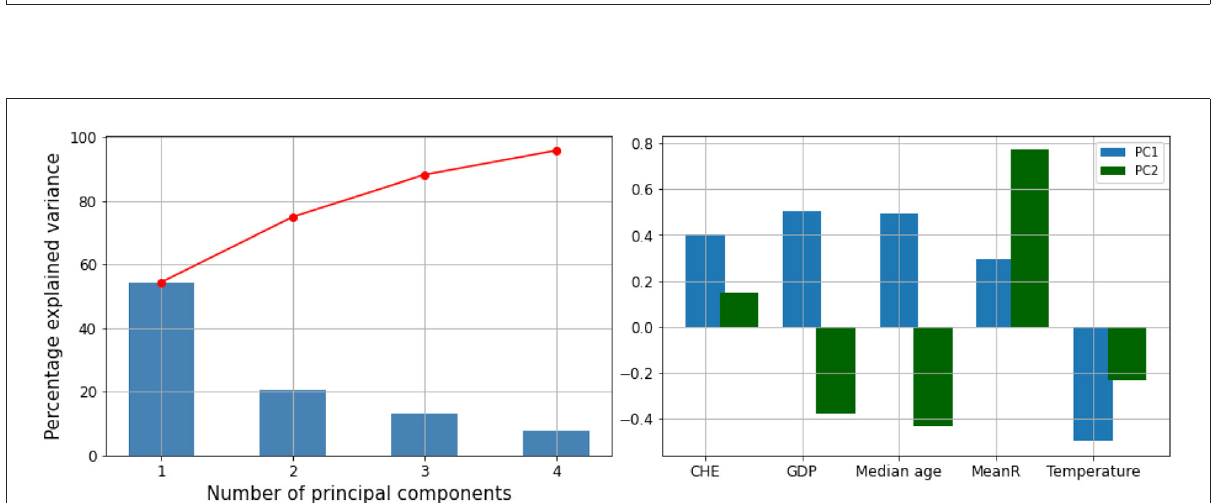
FIGURE7 Hierarchical clustering (Dendrogram) for the pandemic, economic, demographic, and climatic variables allows countries to be grouped into 3 separate clusters.